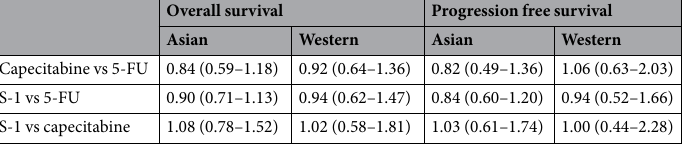
Table 2. Network meta-analysis stratified by Asian and Western studies in overall survival and progression free survival. Relative effects in combined hazard ratio and 95% Credible Intervals (95% CrI) derived from network- meta analysis for capecitabine, 5-FU and S-1 based cytotoxic regimens stratified by Asian studies and Western studies for overall survival and progression free survival. No significant differences were found among Asian and Western patients in efficacy between all fluoropyrimidines. Abbreviations: 5-FU: